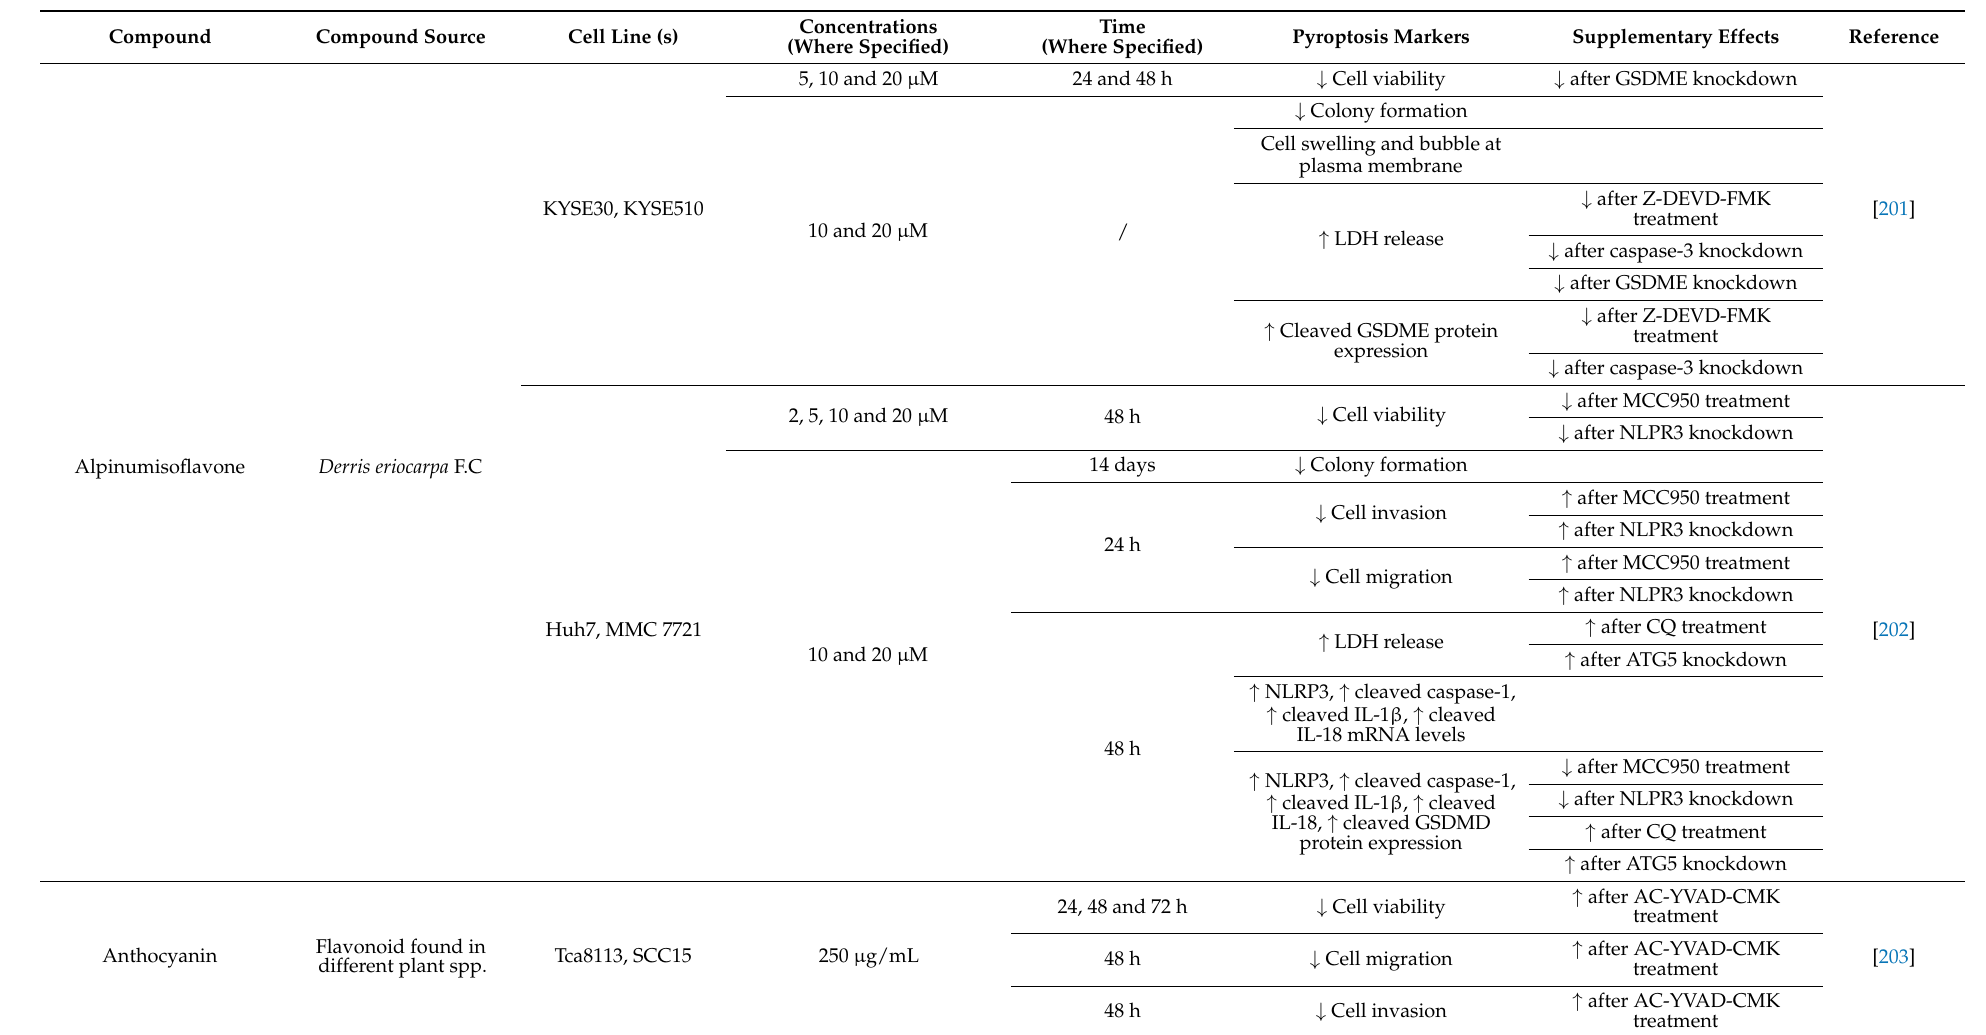
Table 3. Natural products as in vitro inducers of